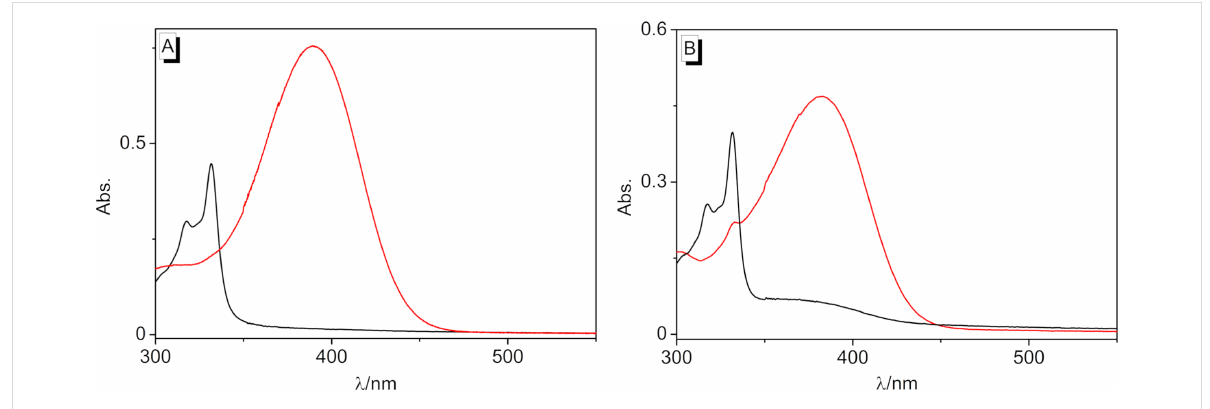
Figure 6: Absorption of the monomers ( c = 20 µM, red) 3b (A) and 3c (B) and their dimers (black) 4b and 4c in H 2 O after 1.5 h and 4 h, respectively, at ca. 450 nm.